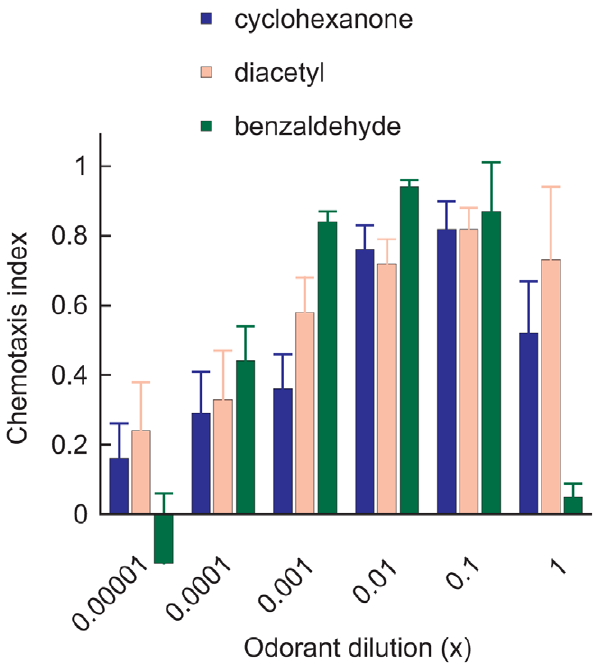
Figure. 1. C.elegans chemotaxis indicates the presence of a high affinity receptor for cyclohexanone. Log concentration- response curves for the chemotaxis of wild-type N2 nematodes to cyclohexanone (blue) compared with the responses to the AWA- directed odorant diacetyl (pink) and AWC-directed odorant benzalde- hyde (green). Each bar represents the mean 6 sem of at least four independent assays involving two plates each.